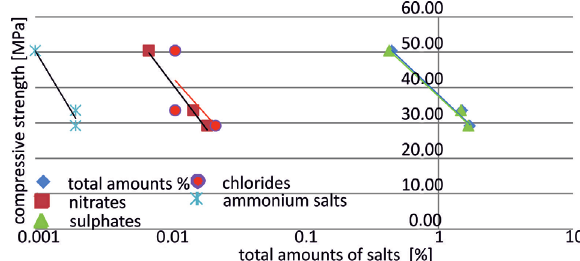
Fig. 7. The effect of the content of selected salts on the compressive strength of sandstone